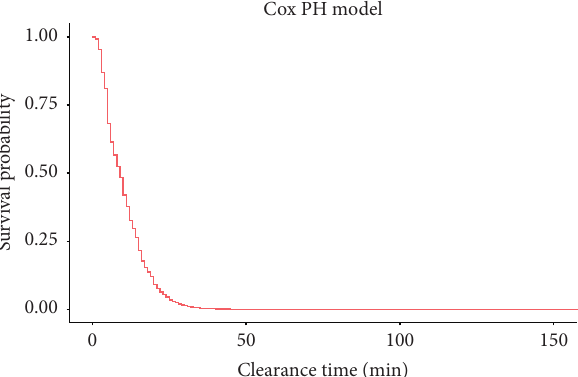
Figure 2: Estimated survival probability for the Cox PH model.